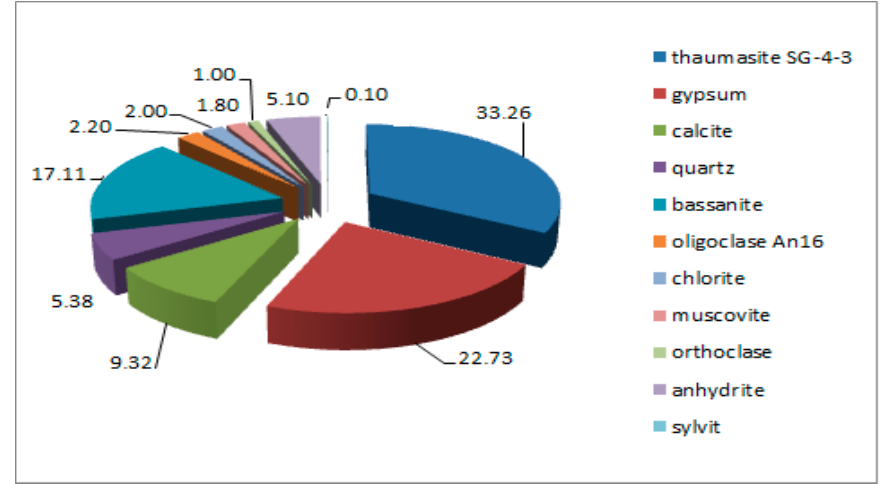
Figure 1. Mineralogical analysis of solids sample (Stage 1) acquired from waste sludge water [%].